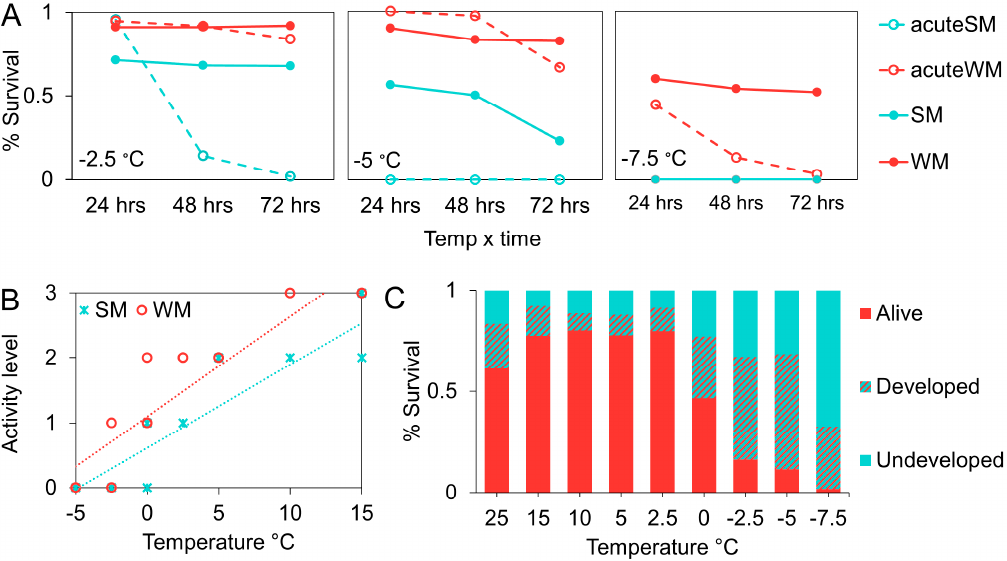
Figure 7. Mean percent survival at sub-freezing temperatures was compared among flies undergoing dynamic acclimation (SM and WM) with those acutely exposed (acute SM and acute WM) ( A ). The relationship between temperature and mean activity level in adult D. suzukii ( B ). Greater values indicate greater activity level. The dashed lines indicate best fit for SM (blue line) and WM (red line) flies. The effect of gradual cooling on pupal survival and development ( C ).